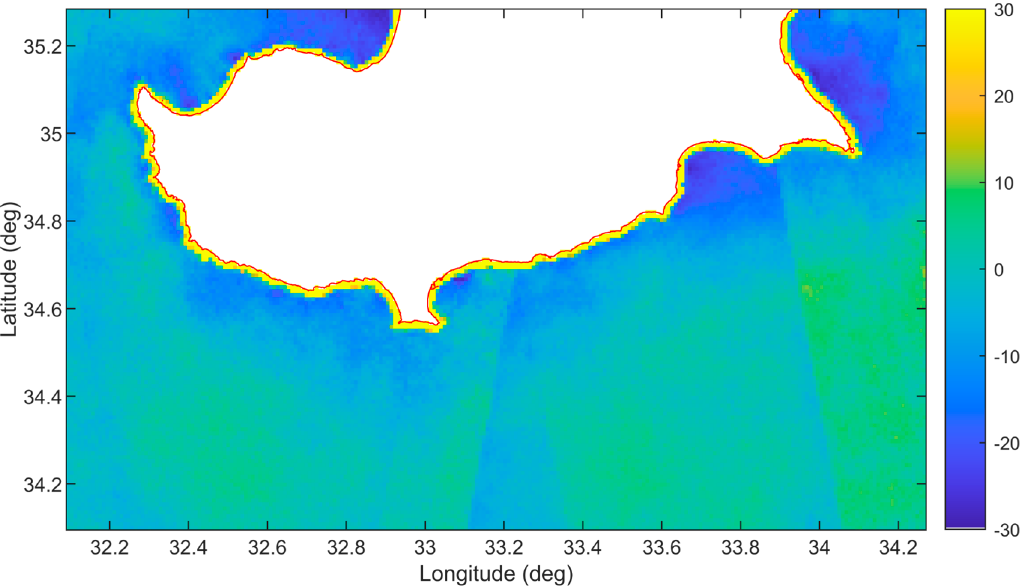
Figure 10. Median relative bias plot (%) resulting from the relative bias between the reference and the mean of 50 realizations at each simulation time step.